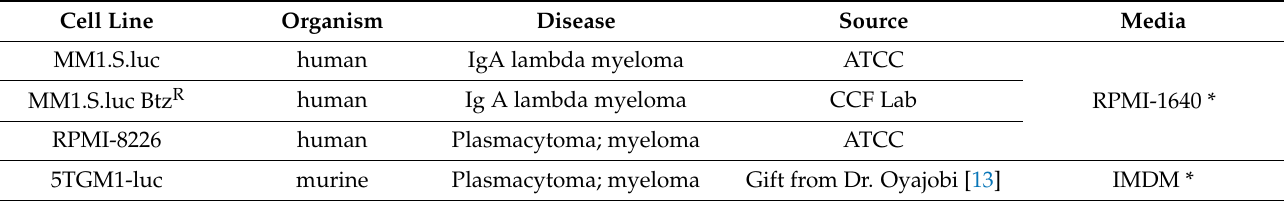
Table 1. Cell line and culture